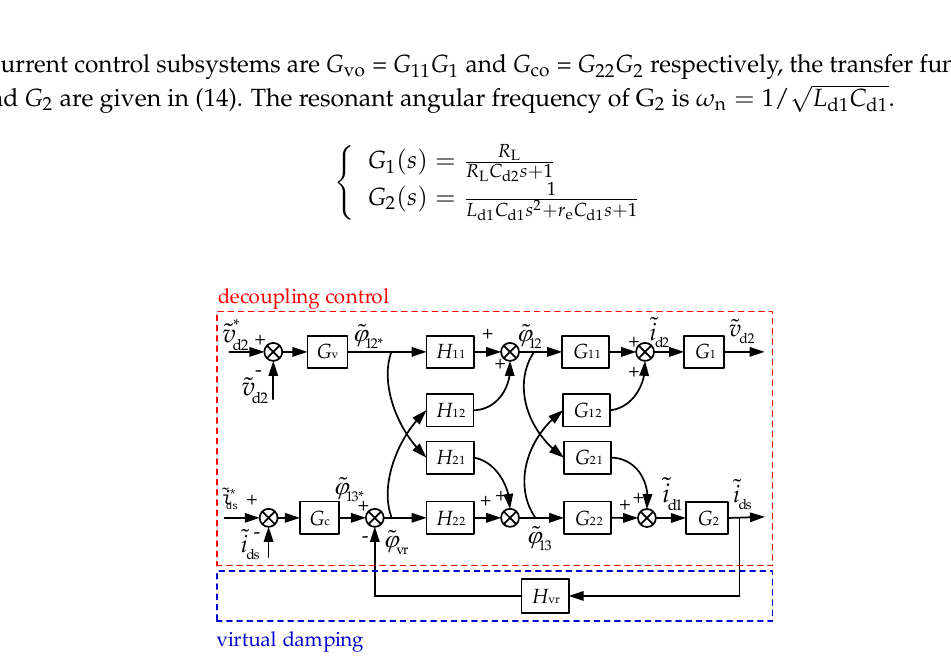
Figure 2. Decoupling control scheme of a three-port converter.